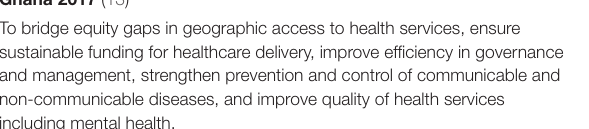
TABLE 2 | Issues addressed by national medicines policies in the selected African countries. The main aim of a National Medicines Policy in the selected African countries is to make available and accessible medicines with the required clinical effectiveness, safety, and quality for evidence based use, and that those provided are cost-effective in their therapeutic group and appropriate to that